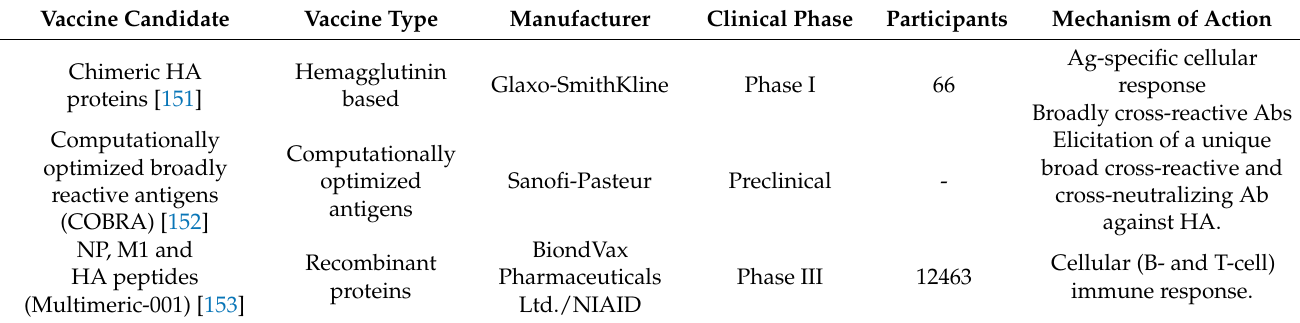
Table 3. Universal influenza vaccine candidates in preclinical and clinical